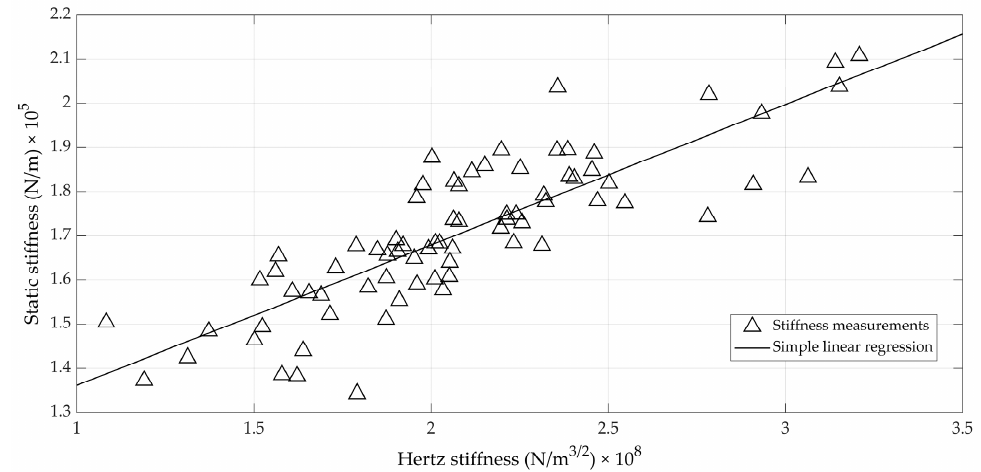
Figure 8. Scatterplot of static stiffness measured during quasi-static compression using a Universal Test Machine as a function of the Hertz stiffness measured in the experimental set-up.